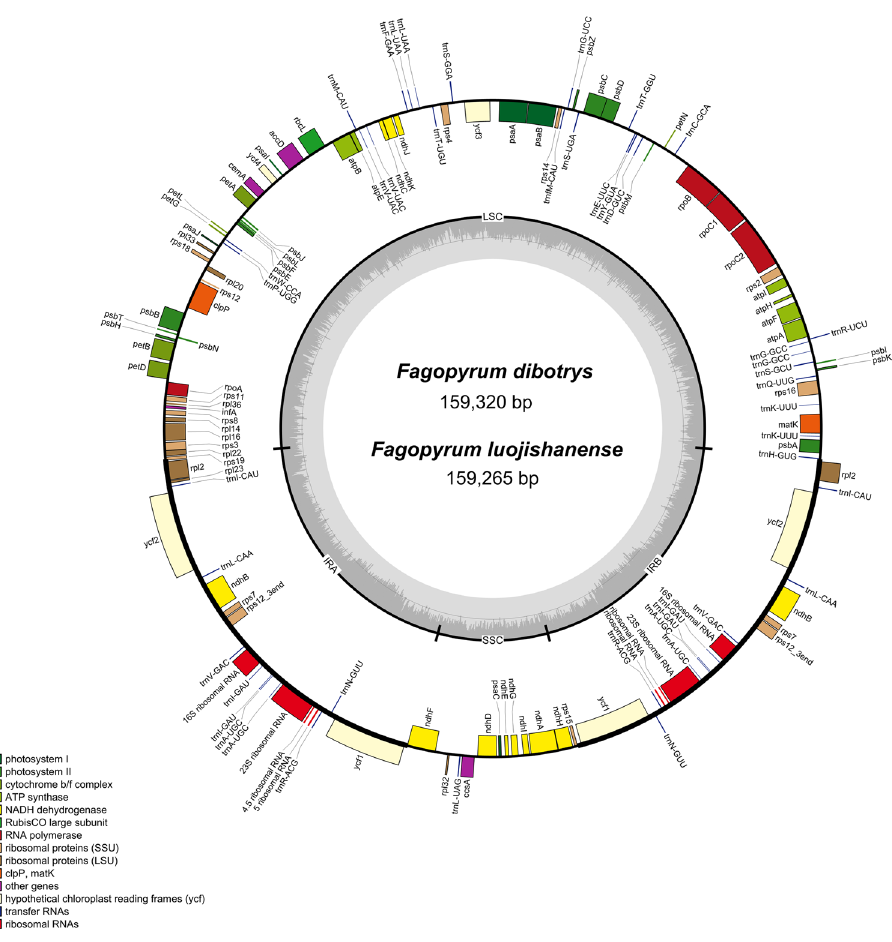
Figure 2. Gene map of Fagopyrum loujishanenes and Fagopyrum dibotrys . The annotation of the genome was performed using DOGMA. The genes shown outside of the circle are transcribed clockwise, while those inside are